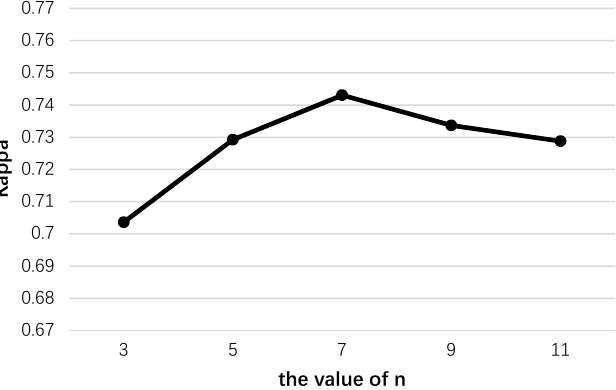
Figure 11. Parameter selection experiment for selecting n on the River data set.